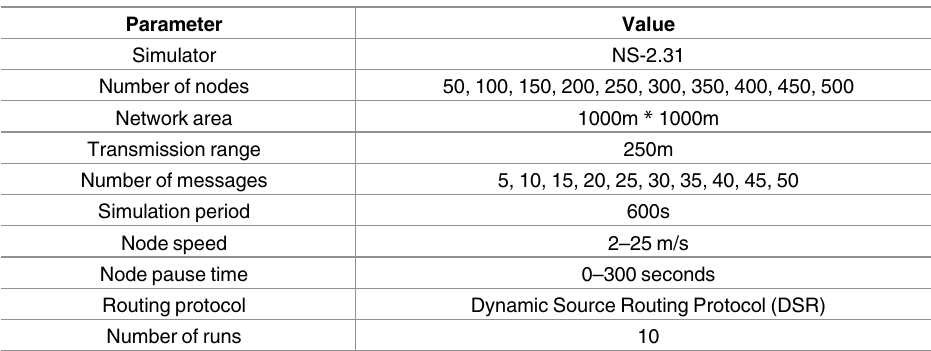
Table 1. Simulation